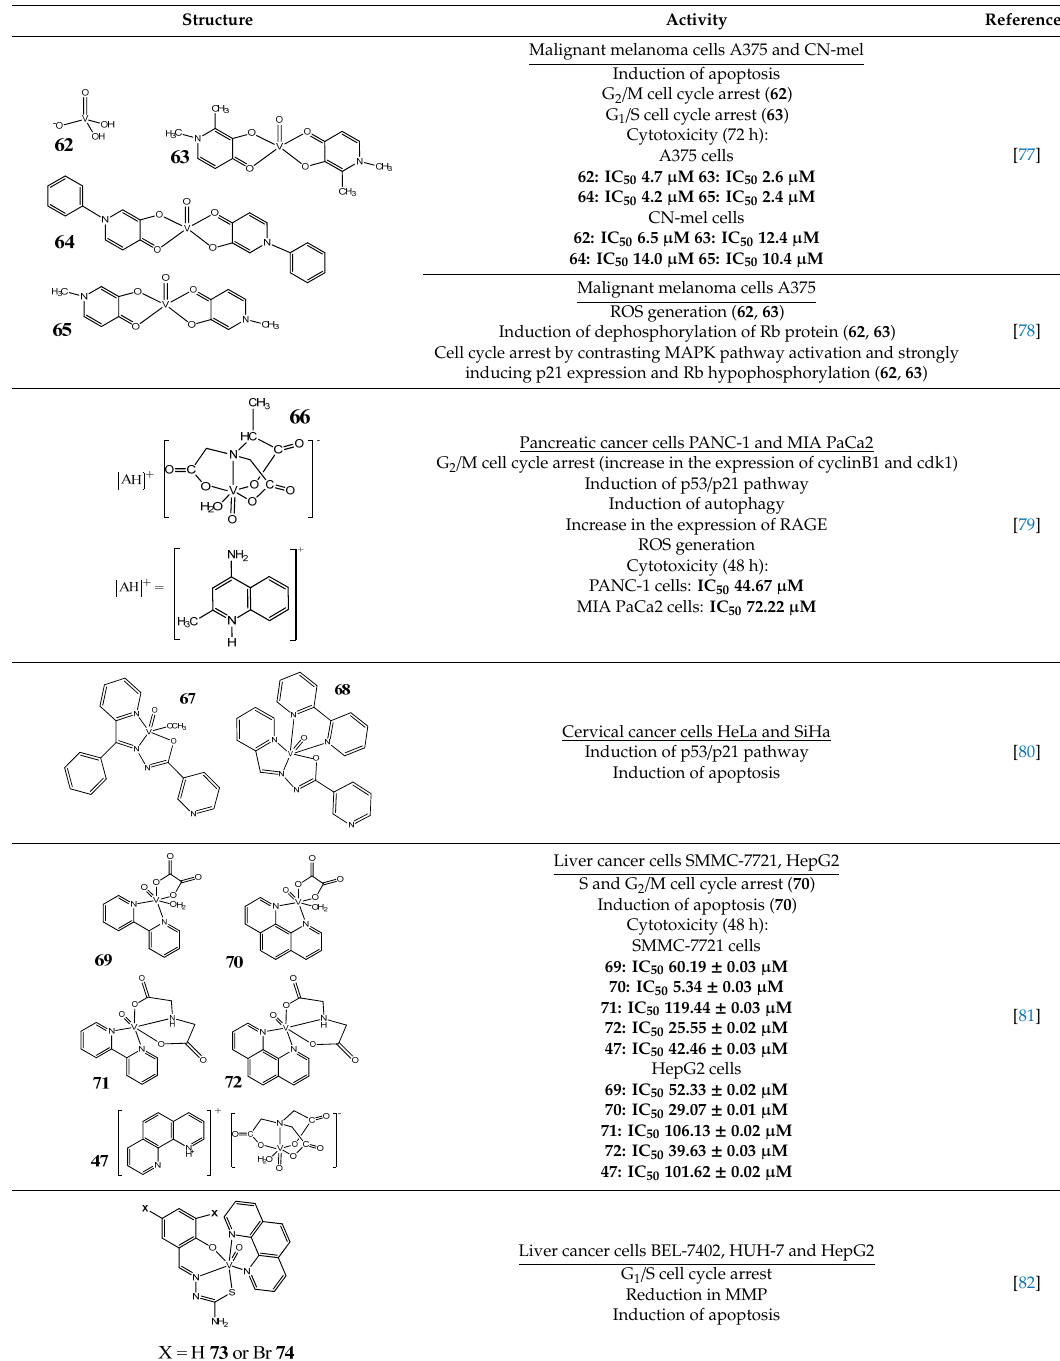
Table 3. Cont. Structure